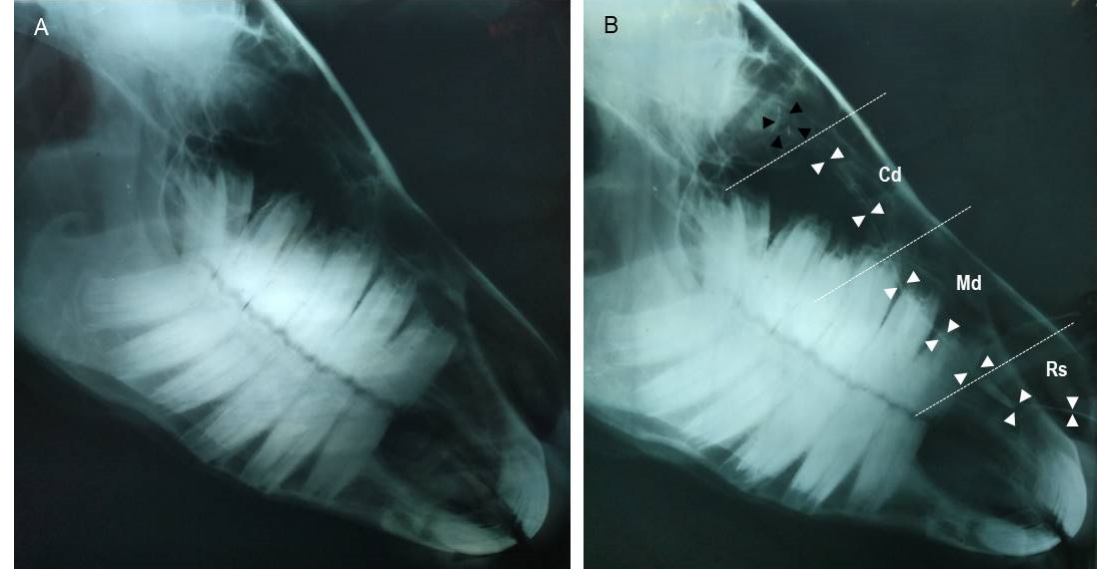
Figure 2. ( A ) Representative lateral plain radiograph of the head region of a healthy adult donkey. ( B ) Lateral contrast radiograph of nasolacrimal drainage system (dacryocystorhinography) outlining that the NL duct (whit arrow heads) has 3 portions according to the width change during its course, as well as the NL sac (black arrow heads) of a healthy adult donkey. Rs: rostral cartilaginous segment; Md: middle membranous segment; Cd: caudal osseous segment.